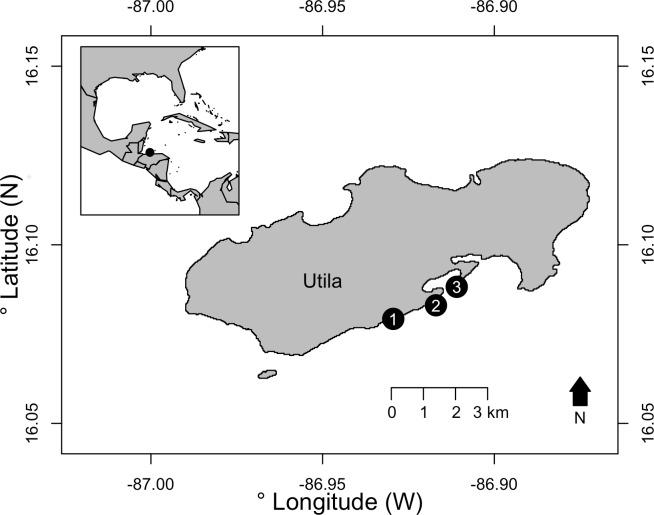
The three survey sites on the south shore of Utila, Bay Islands, Honduras.Sites were: (1) Little Bight, (2) Black Coral Wall and (3) Coral View. See Table S1 for full GPS location data. Inset —The location of Utila is indicated with a black circle relative to the western Caribbean and Gulf of Mexico.